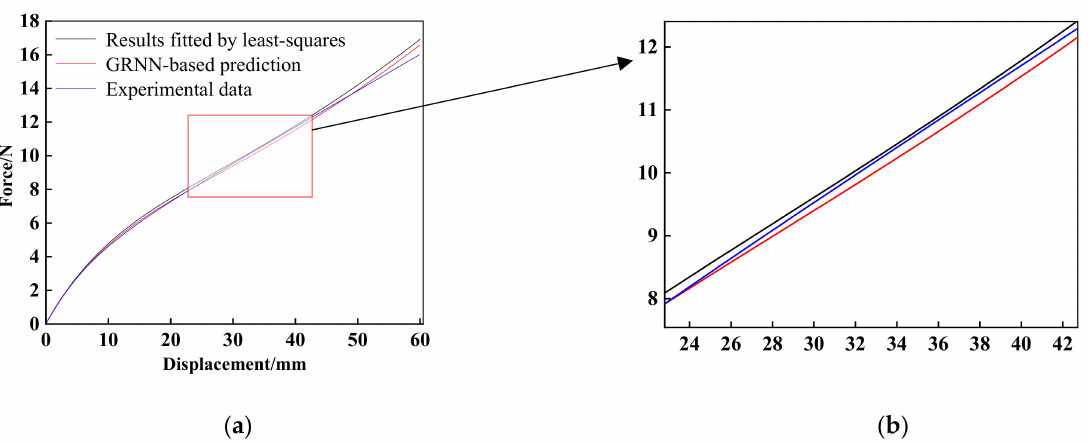
Figure 11. ( a ) Results obtained by using the Ogden model ( N = 3); ( b ) The partially enlarged views for specific deformation stages based on Ogden model ( N =